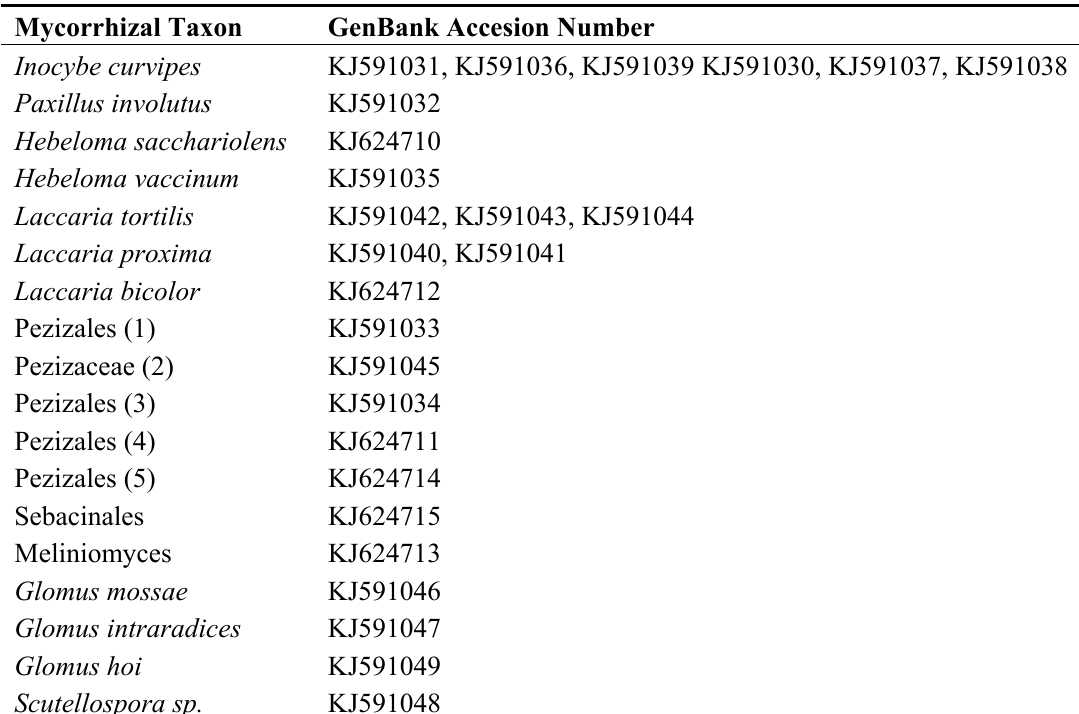
Table 2. Identification of ECM and AM associated with the seven poplar clone types (according to NCBI [24] and UNITE [25]